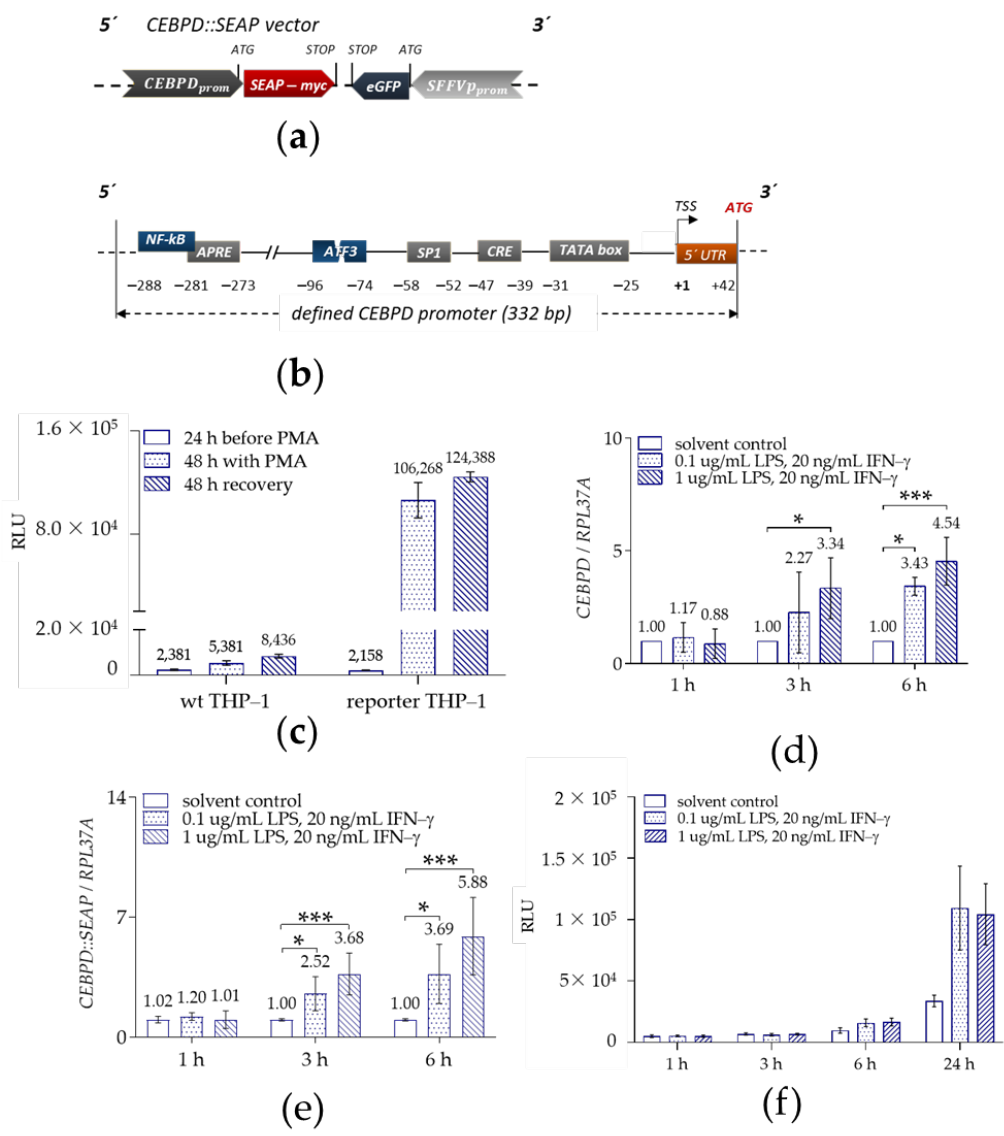
Figure 2. SEAP is a reliable gene reporter for CEBPD monitoring in THP-1 reporter macrophages (M φ ). Schematic drawing of the generated CEBPD::SEAP vector ( a ) and of the defined CEBPD promoter ( b ) containing 5’UTR, TSS, TATA box, known (gray boxes), and proposed (blue boxes) binding sites of regulatory TFs. Positions in base pairs (bp) are indicated relative to the TSS (0). ( c ) The cell culture medium from THP-1 wild type (wt) and reporter cells was collected 24 h before, during (48 h with PMA), and after (48 h recovery) treatment with 50 ng/mL PMA for SEAP assay (mean ± SD, n = 3). In ( d , e ) PMA-differentiated THP-1 reporter M φ were stimulated with PBS (solvent control), 1 µ g/mL or 0.1 µ g/mL LPS + 20 ng/mL IFN- γ for up to 6 h for mRNA expression analysis of endogenous CEBPD ( d ) and reporter CEBPD::SEAP ( e ) (mean ± SD, n = 3). mRNA expression analysis was performed via qRT-PCR ( ΔΔ Ct method) using RPL37A as an internal reference gene. Differences in CEBPD gene expression levels were analyzed relative to PBS via one-way ANOVA or Kruskal – Wallis test with Dunn ’ s correction for multiple comparisons. * p < 0.05; *** p < 0.001. ( f ) The cell culture medium from PMA-differentiated THP- 1 reporter Mϕ were collected after treatment with PBS (solvent control), 1 µg/mL or 0.1 µg/mL LPS + 20 ng/mL IFN- γ for 1, 3, 6, or 24 h (mean ± SD, n = 3). SEAP enzymatic signal was monitored for 40 min after substrate addition. RLU: relative luminescence units.